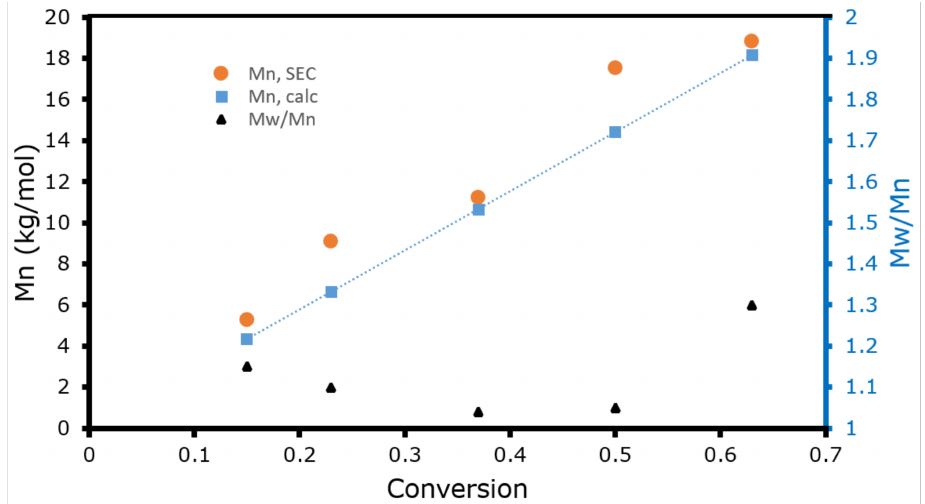
Figure 1. Experimental (Mn SEC) and theoretical (Mn calc) number-average molecular mass, and dispersity versus conversion for polyMEMA.